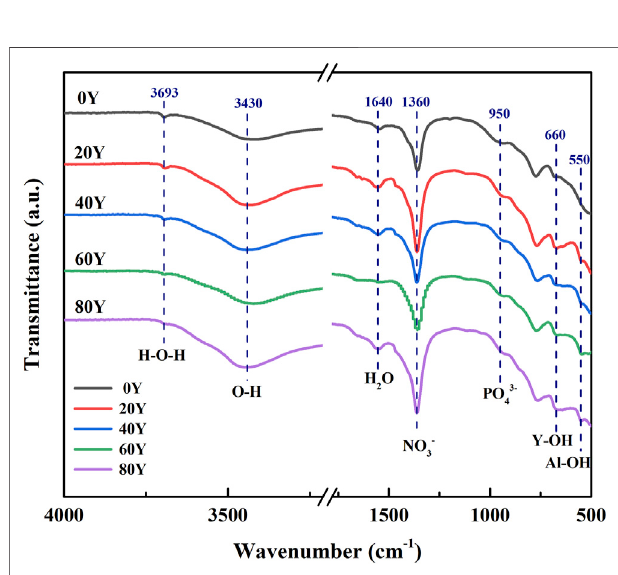
FIGURE 4 | FT-IR pattern of different